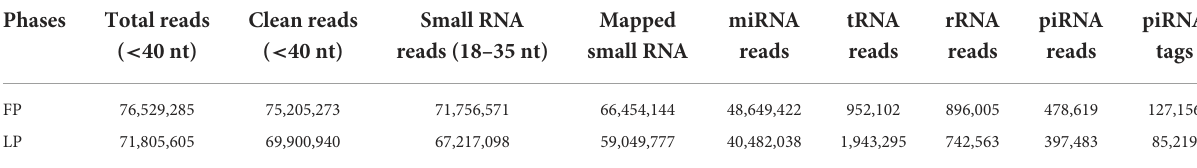
TABLE 1 Summary of sequencing data of small RNA and piRNAs in ovine ovaries.